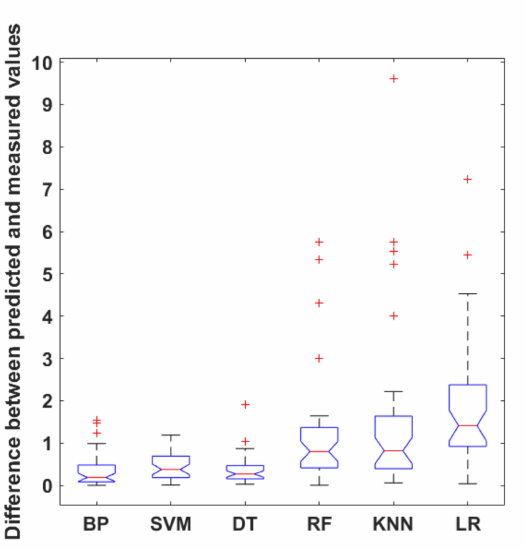
Figure 8. Box plot of the results comparison of proposed ML algorithms.